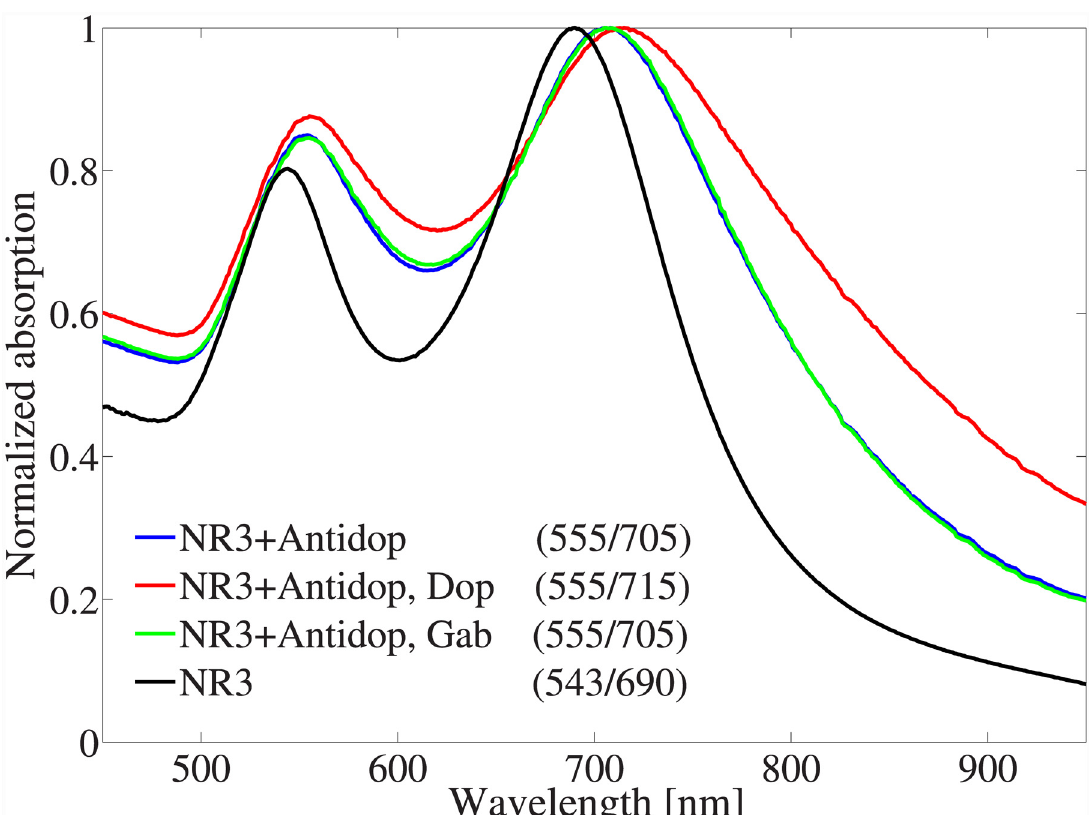
Fig 5. The standard results set for NR3 using Antidop as the receptor and Dop as the neurotransmitter. The numbers in parenthesizes report the peak wavelengths of each curve in units of nm